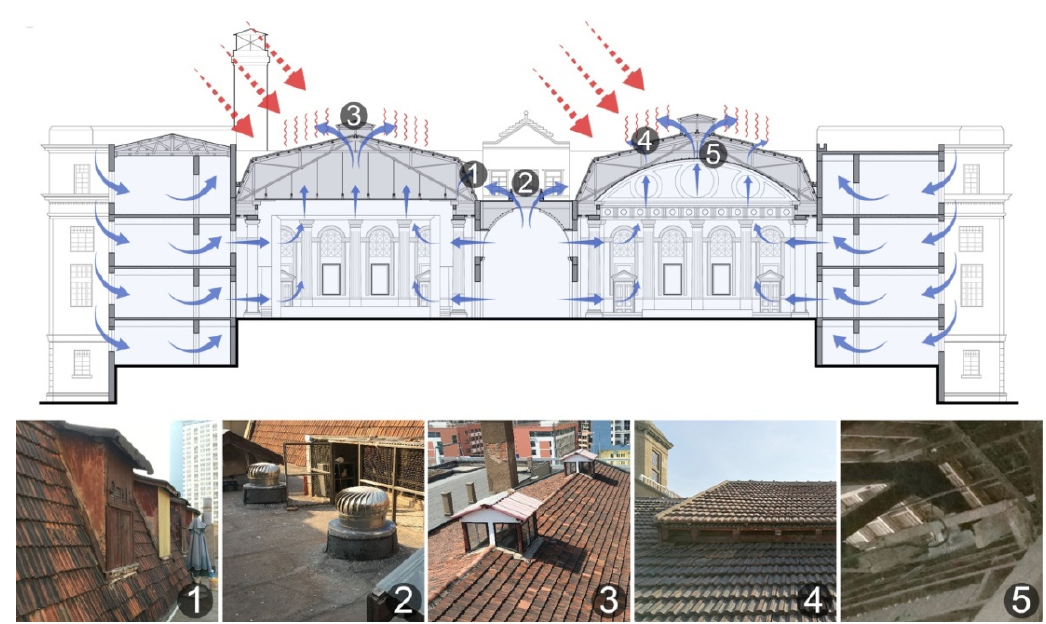
Figure 18. Ventilation System.